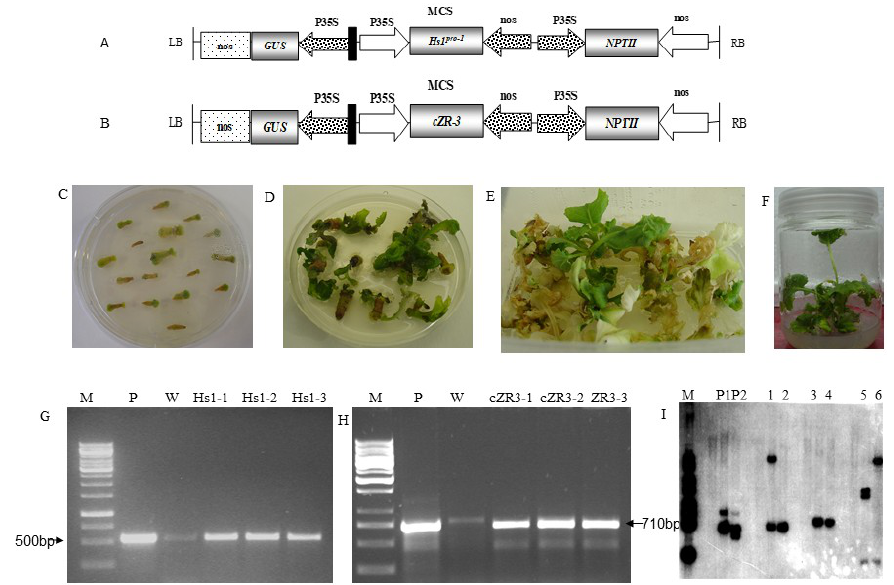
Figure 1. Generation and identification of transgenic Hs1 pro-1 and cZR3 plants from hypocotyle explants of B. napus cv. Zheshuang 758 by A. tumefaciens mediated transformation. ( A , B ) Diagram